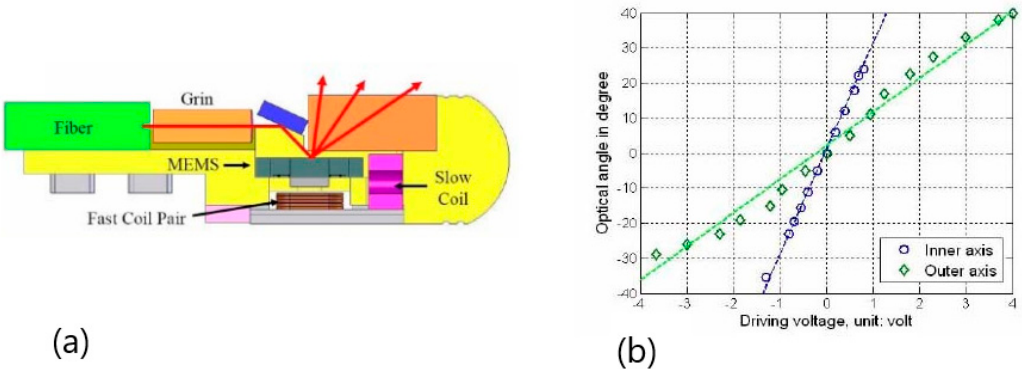
Figure 15. Schematic of the assembled catheter packaging in ( a ) and optical angles of the MEMS scanner for both axes vs. the driving voltage in ( b ) (Figures from [55]).